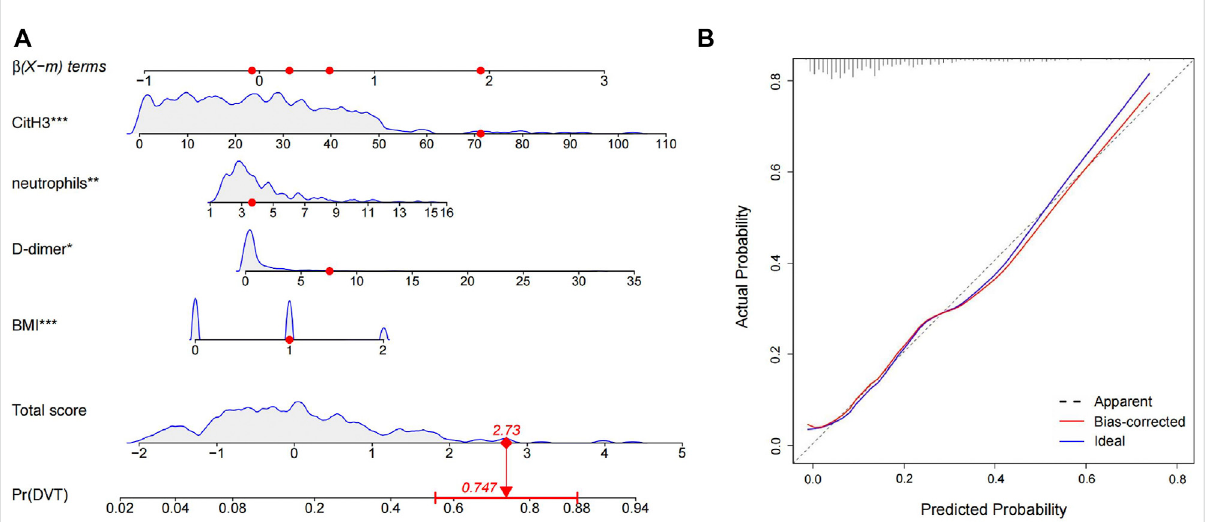
FIGURE 4 Nomogramandthecorrespondingcalibrationcurvefor predictingtheriskofoperativeDVT. (A) Four predictorswereinvolvedinthepredicting model, and each of them was assigned a graphic score. The sum of these four scores generated a result on the “ total score ” axis, and the “ Pr (DVT) ” axis shows the probability of DVT. Red dots represented the scores of a random patient. (B) The calibration curve of the predictive model for evaluating the risk of postoperative DVT.